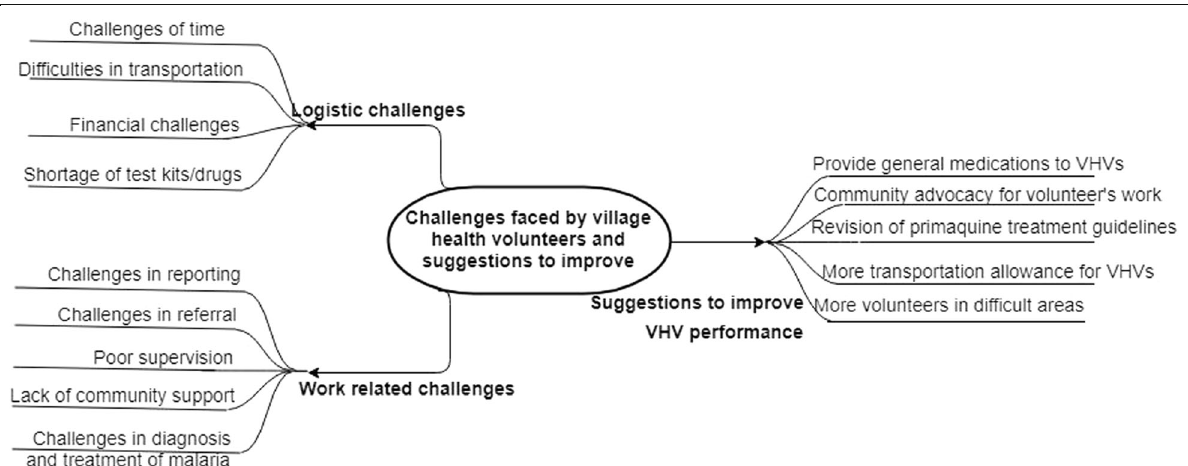
Fig. 6 Thematic diagram showing the themes and sub-themes around challenges faced by village health volunteers, community acceptance for volunteers and suggestions to improve their performance in Myanmar,